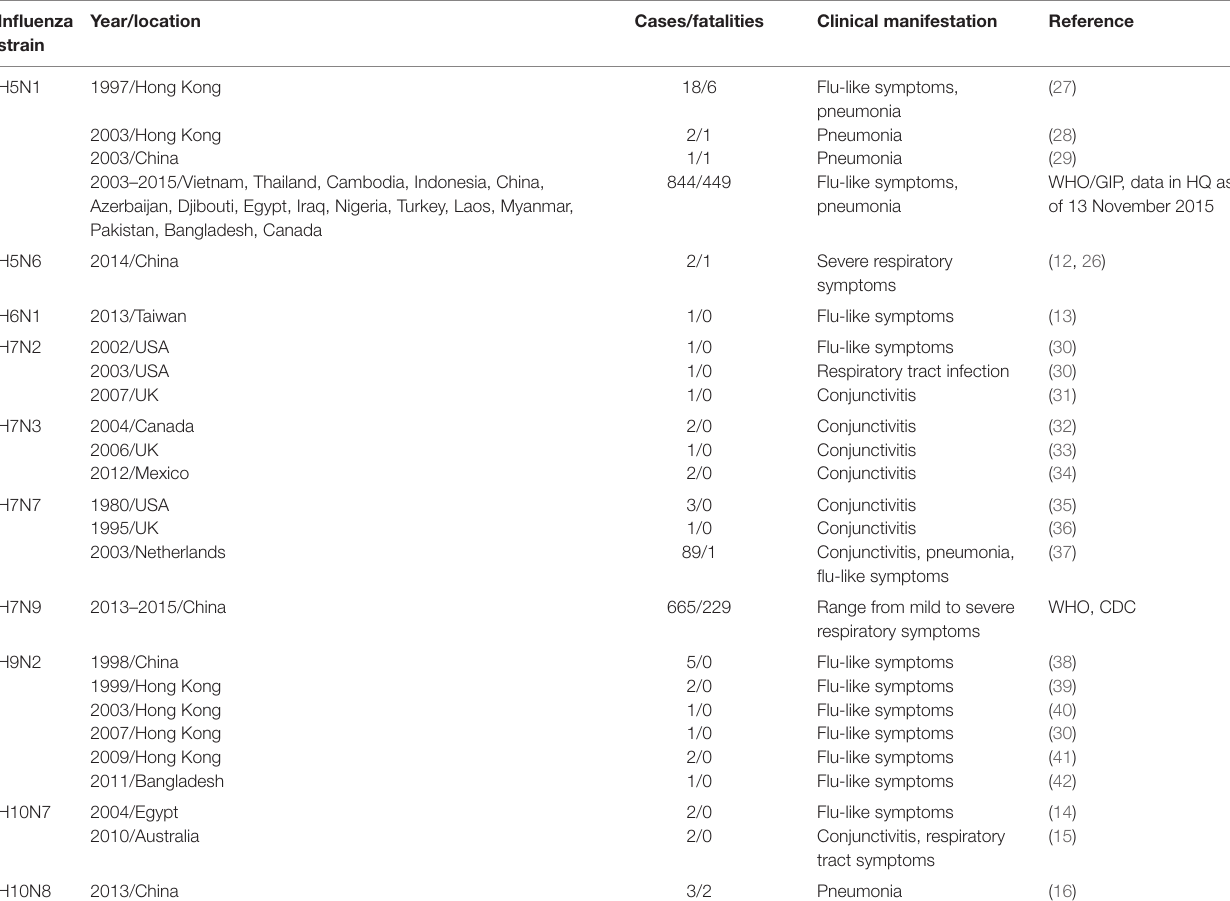
TABLe 1 | Summary of human infections caused by the avian influenza